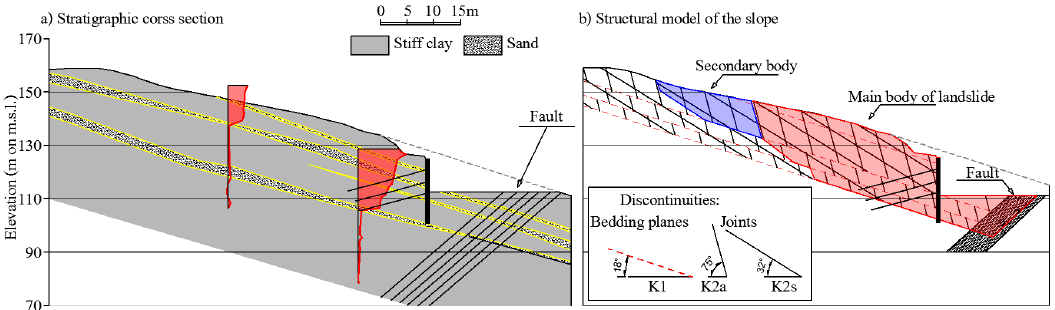
Figure 6. ( a ) Stratigraphic cross-section of the slope with the most significative inclinometer readings; ( b ) structural model of the slope with indication of the landslide bodies.